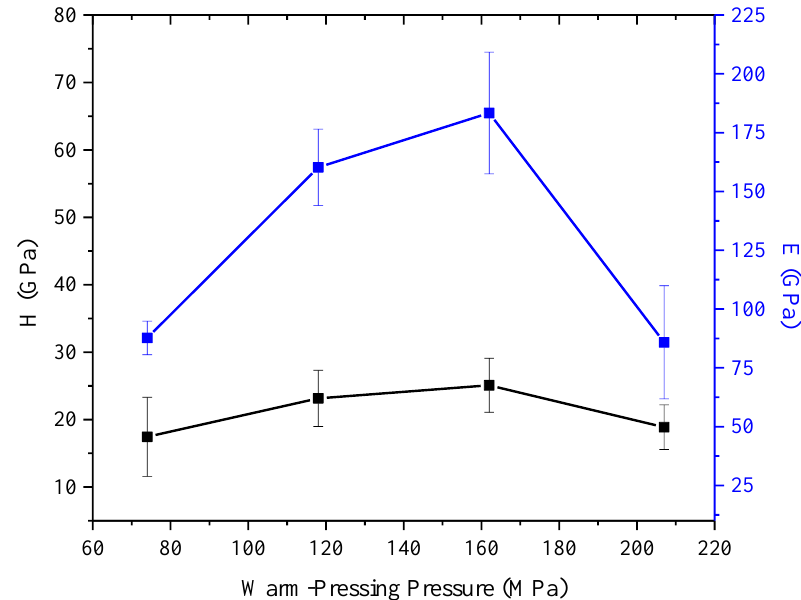
Figure 19. Evolution of the hardness and Young’s modulus of TiN/Si 3 N 4 nanocomposites as functions of the applied warm-pressing